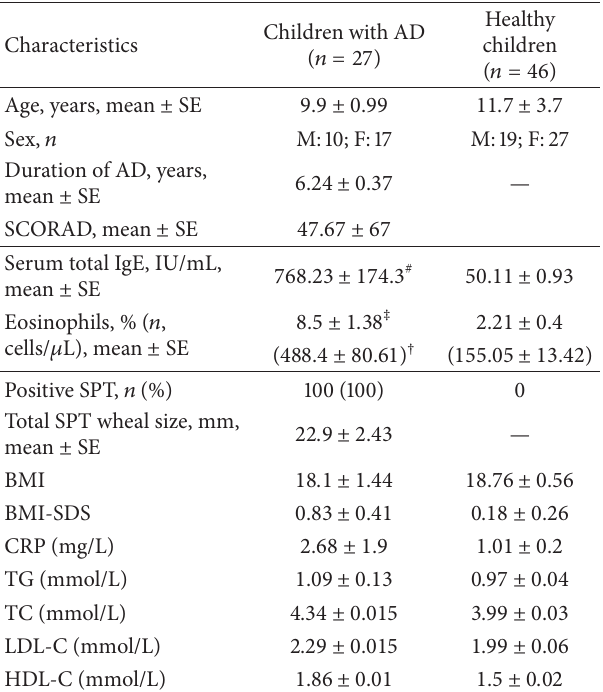
Table 2: Mean values of adipokine serum levels in children with atopic dermatitis and healthy children.